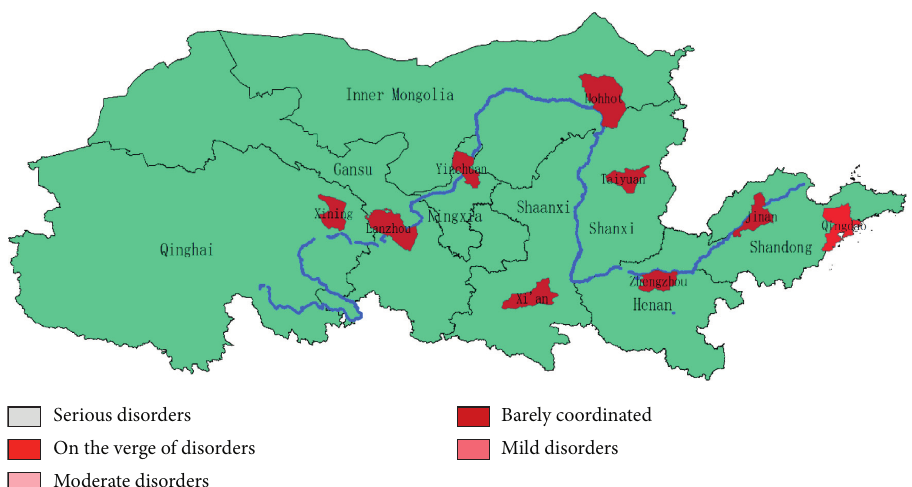
Figure 7: Coupling coordination level of central cities in the Yellow River Basin in